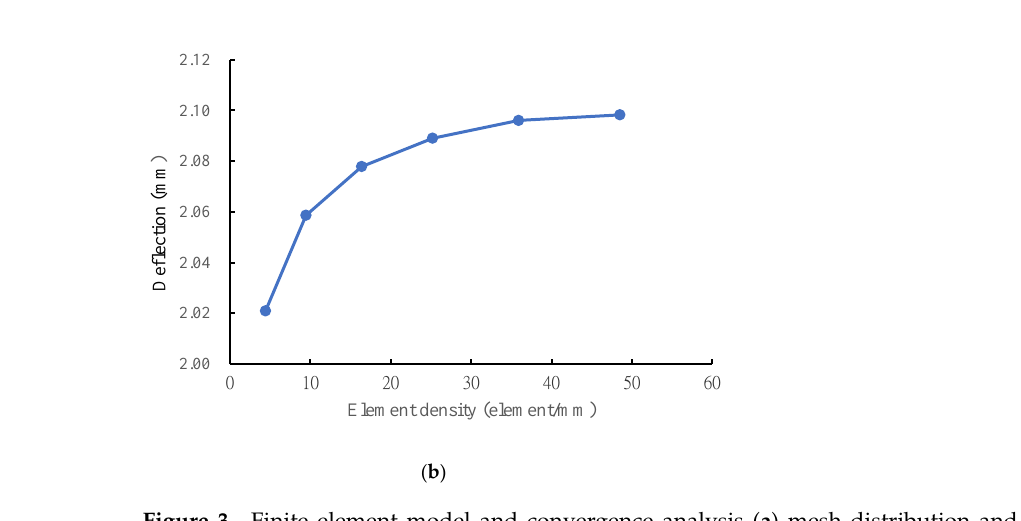
Figure 3. Finite element model and convergence analysis ( a ) mesh distribution and boundary conditions ( b ) element convergence analysis.